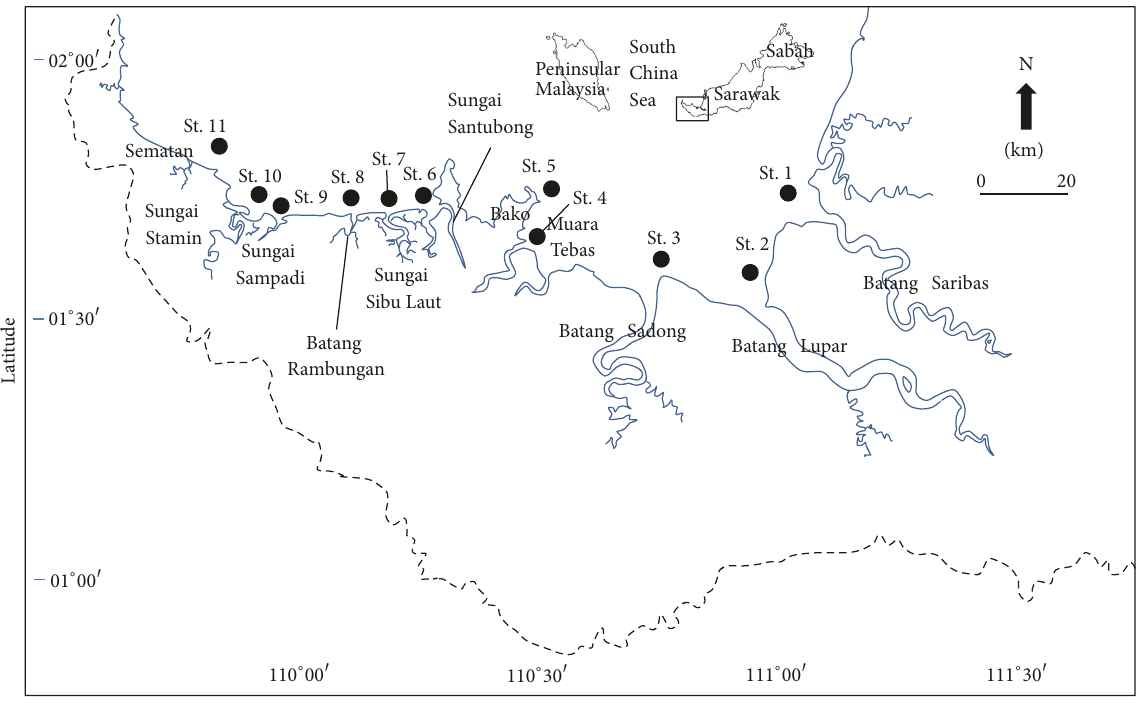
Figure 1: Study area and sampling stations along the coastline of the southwestern region of